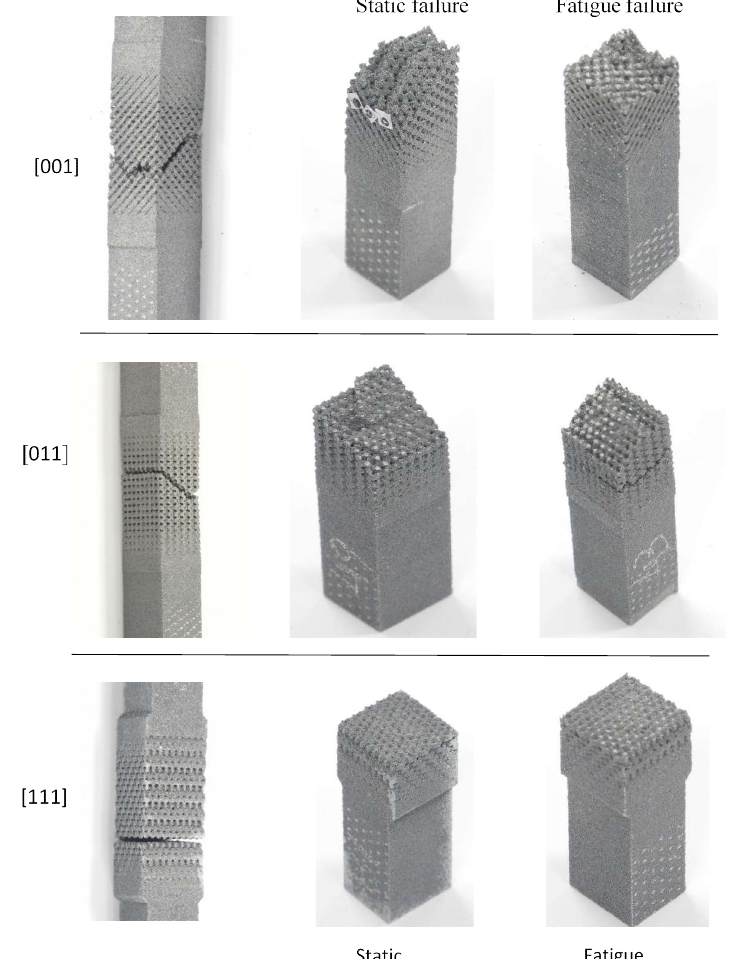
Figure 12. Images of the fracture of the different lattice specimens.